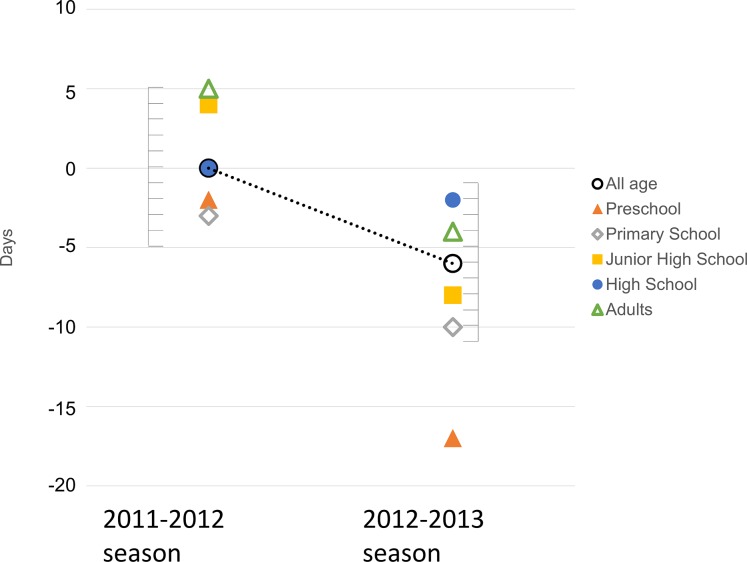
The distributions of Epidemic Midpoint (EM) by age groups in 2011/2012 and 2012/2013 seasons.*Day 0 was set as February 8.